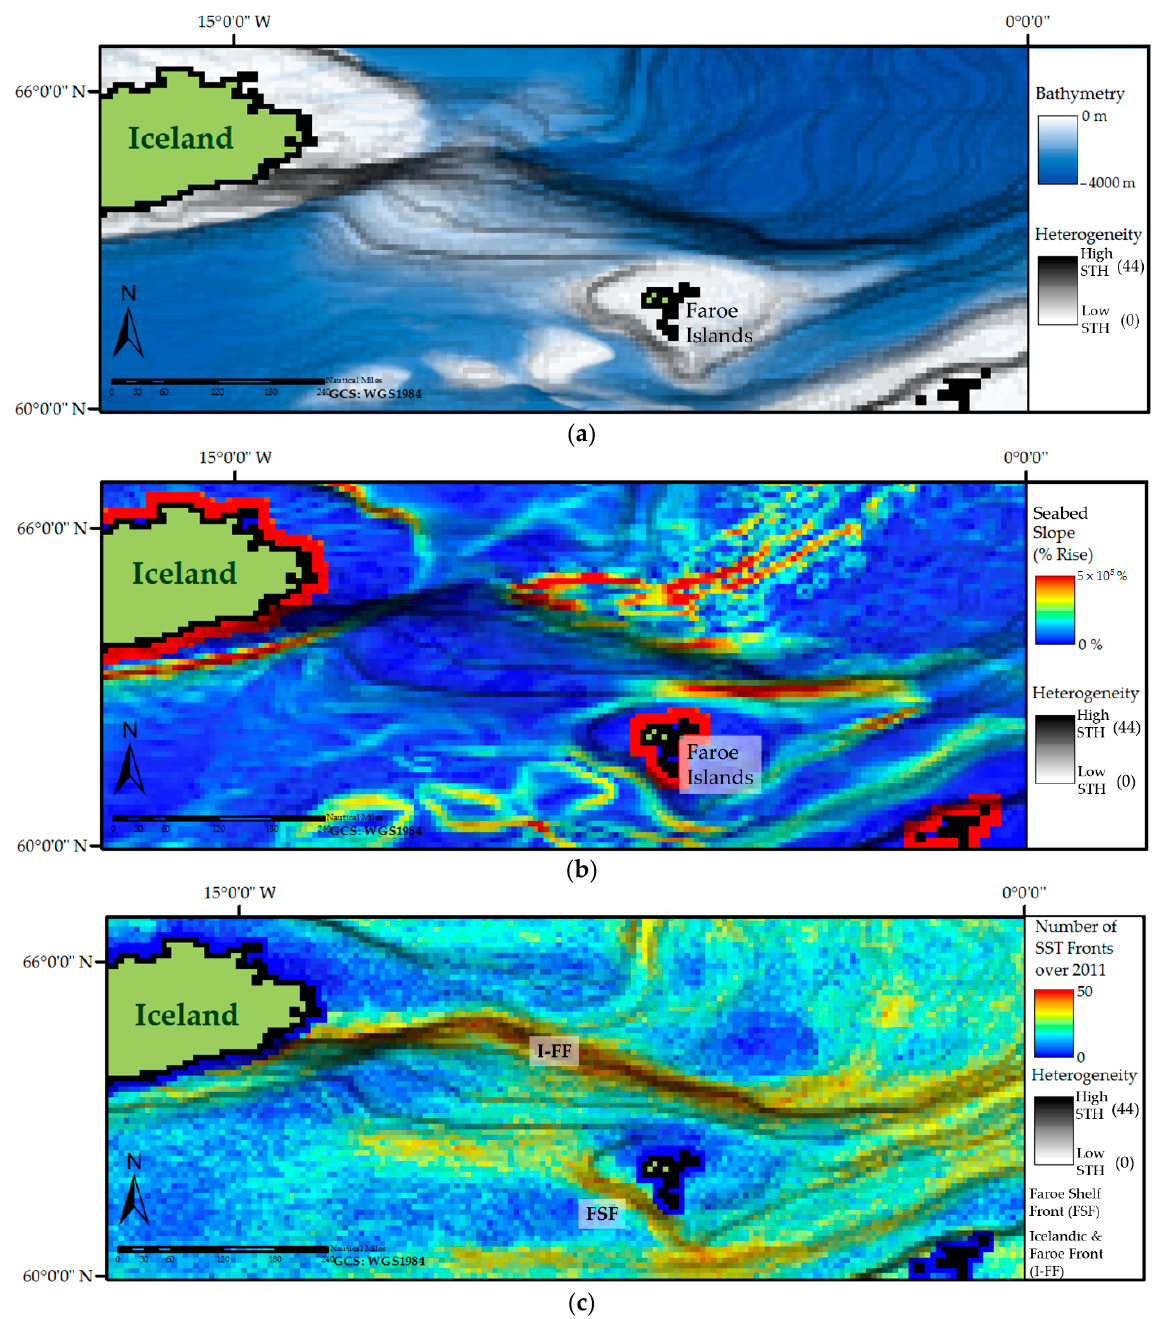
Figure 15. STH in the waters east of Iceland overlying significant parameters identified by the GLM. ( a ) STH overlaying the bathymetry of the IFF region; ( b ) STH overlying areas of steeper slope gradients; ( c ) STH overlying SST front counts for the region over the course of 2011, with the Iceland-Faroe front (I-FF), and Faroe Shelf Front (FSF) highlighted. All panel maps are displayed using only the WGS1984 spheroid.